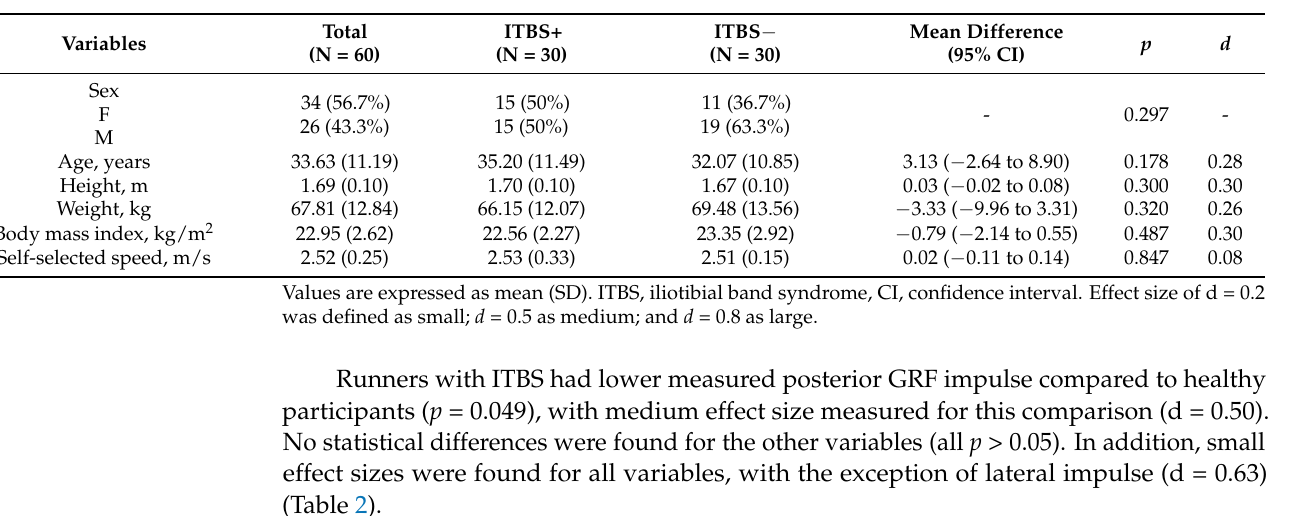
Table 1. General data in running cohort with and without ITBS (n = 60).